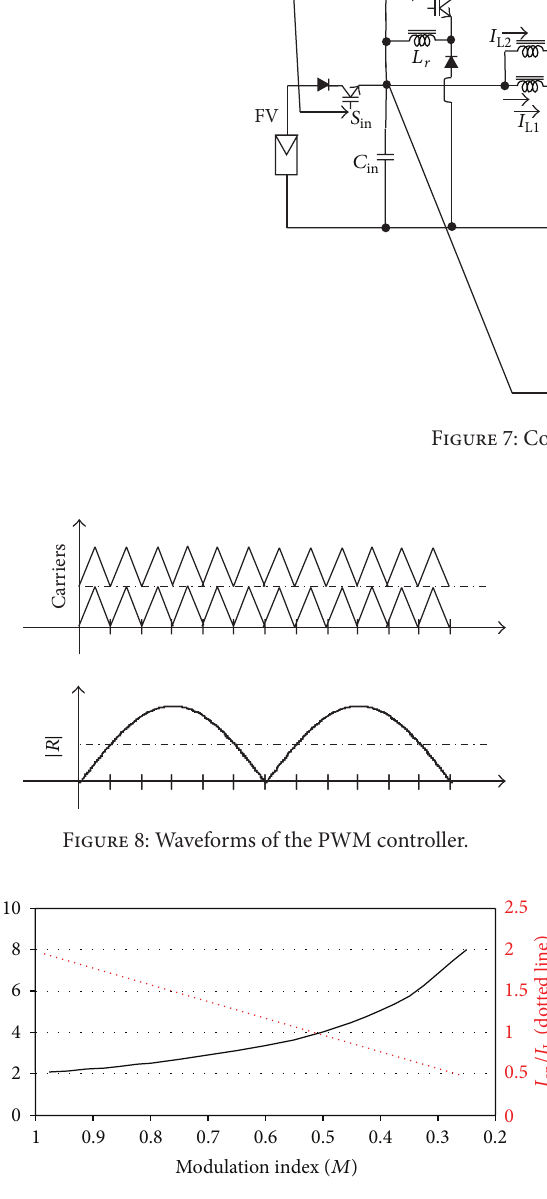
Figure 9: Gain graphs versus modulation